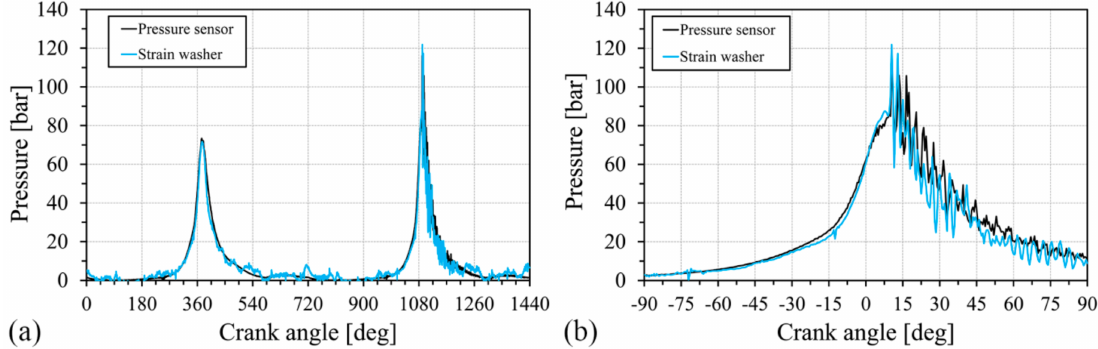
Figure 20. ( a ) In-cylinder pressure of two consecutive cycles with knock event at 5000 rpm and full load measured by the pressure sensor and derived from the strain washer signal; ( b ) zoomed view of the combustion phase during the knocking event.